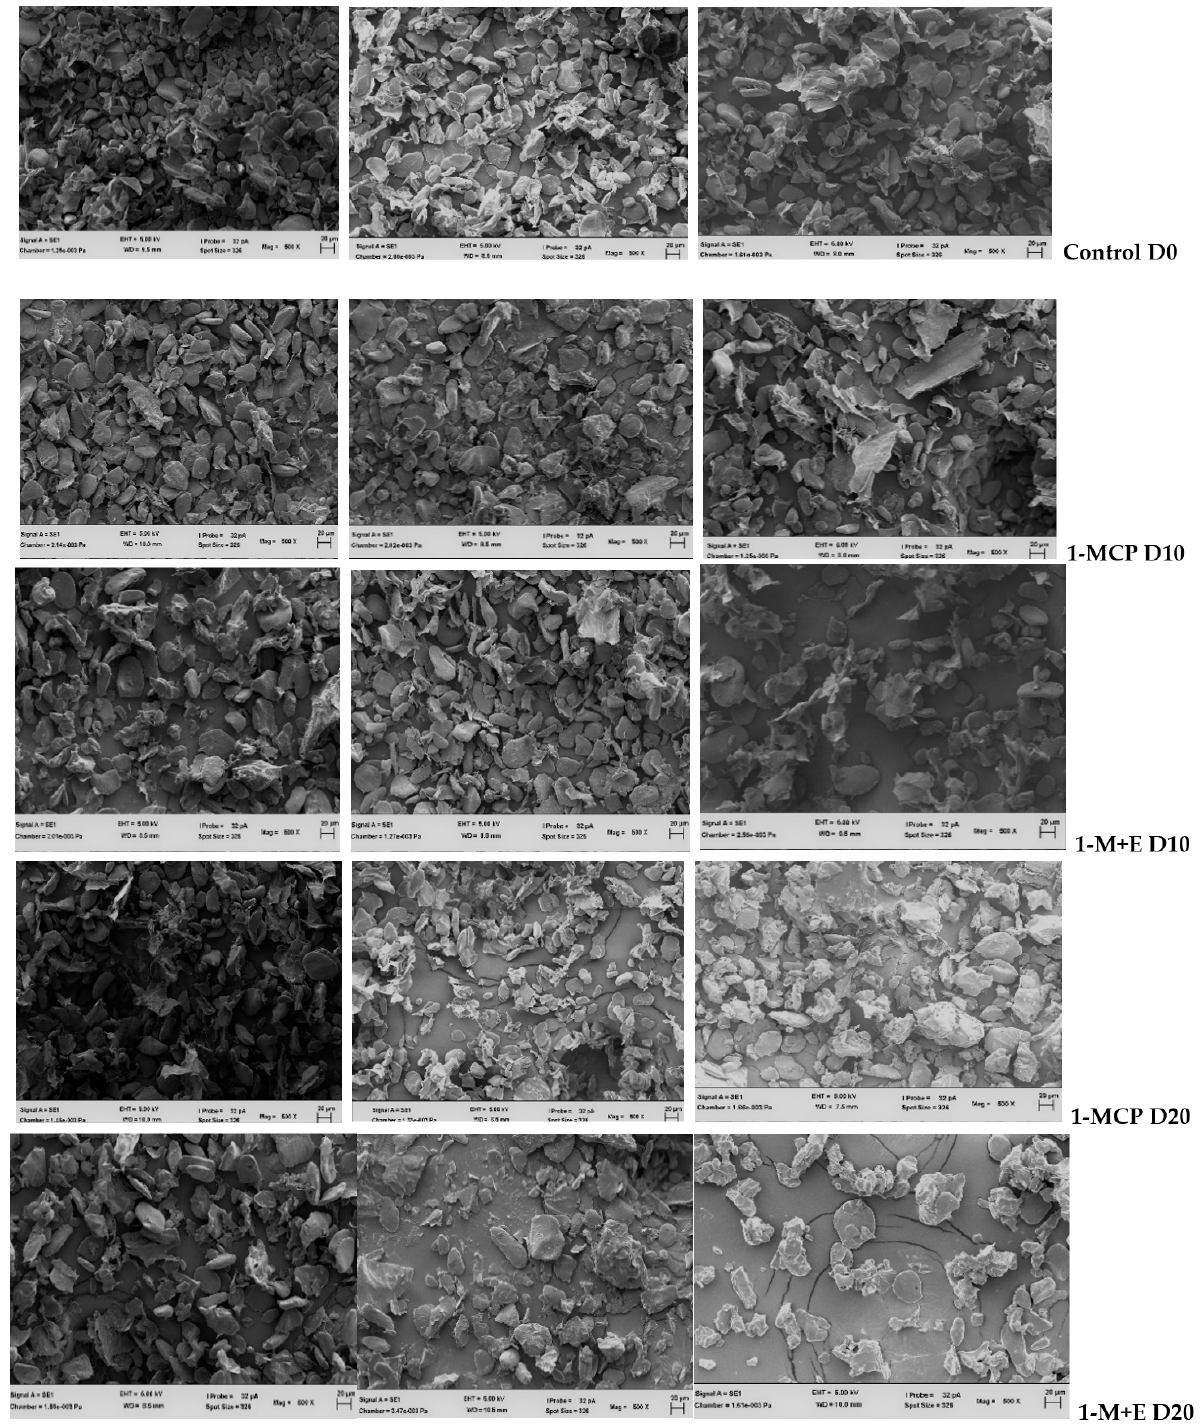
Figure 4. Scanning Electron Microscopy (SEM) images of the starch granules of small (left column), medium (middle column) and large (right column) fruit treated with 1-MCP and ethephon + 1-MCP (1-M+E) during 20 d shelf-life at ambient temperature.